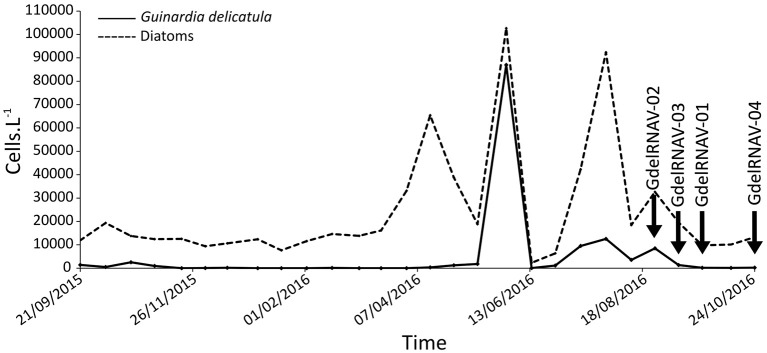
Temporal dynamics of Guinardia delicatula (solid line) and all diatoms (dash line) at SOMLIT-Astan station (Western English Channel) during the September 2015–October 2016 period. All along this period a protocol designed for the isolation of viruses lytic to G. delicatula was applied to seawater samples collected every fortnight. The arrows point to sampling dates on which the virus strains GdelRNAV-01 to 04 were successfully isolated.